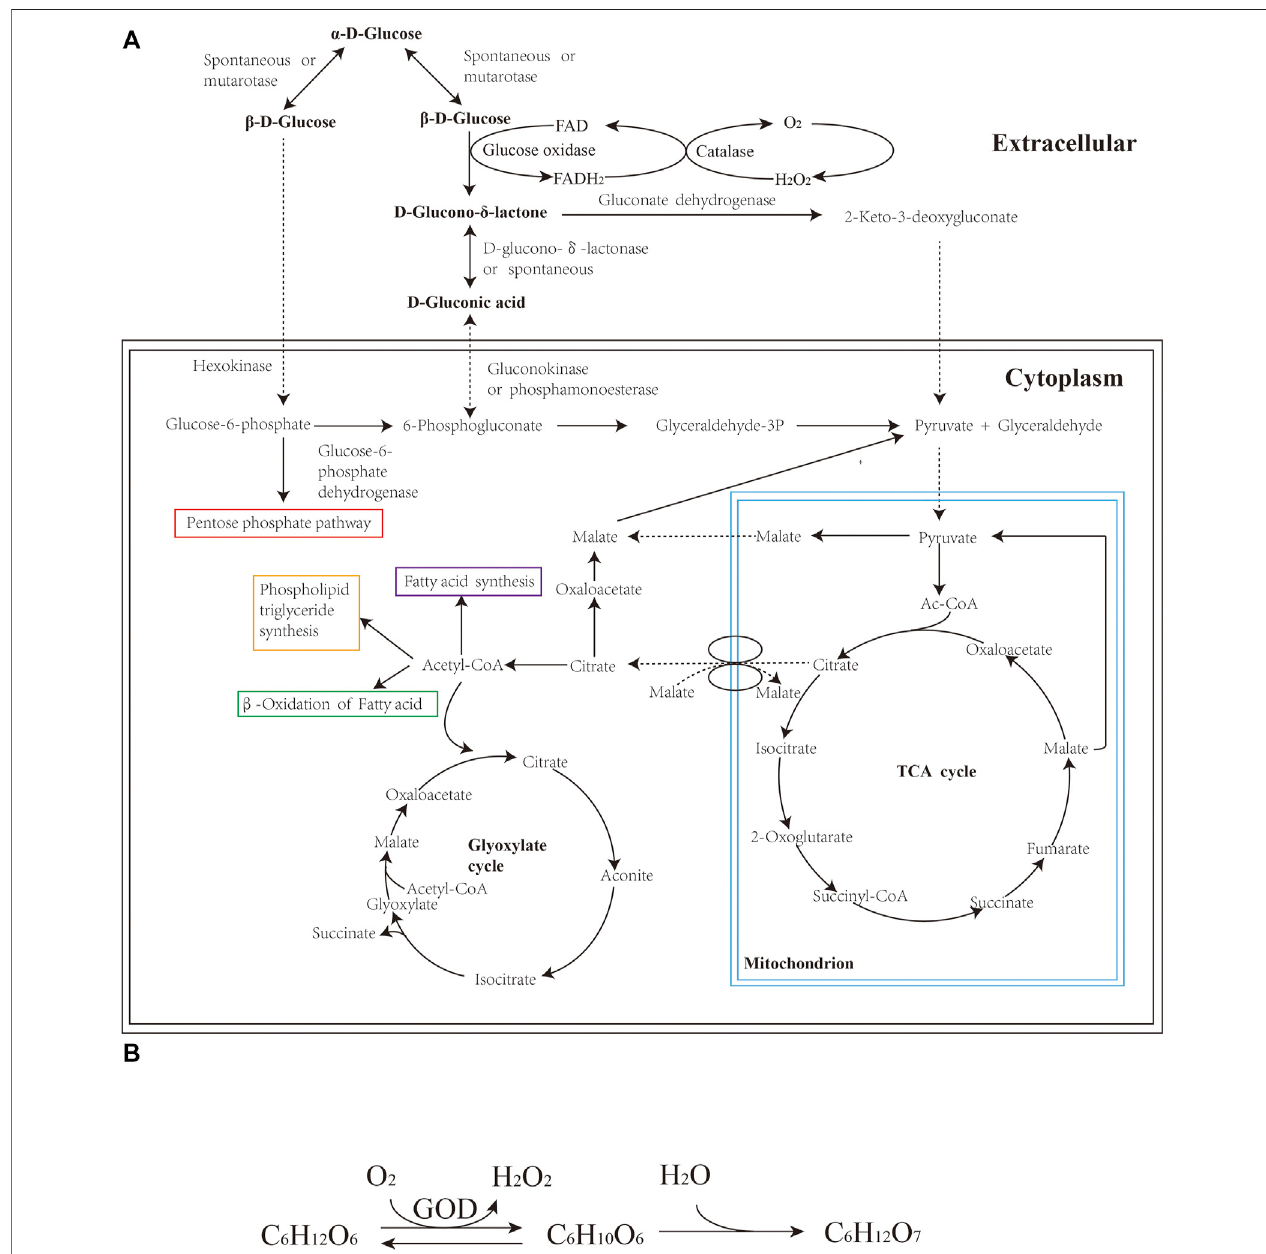
FIGURE 2 | (A) Pathway of GA from glucose in fungi; (B) Overall reaction mechanism of GA in